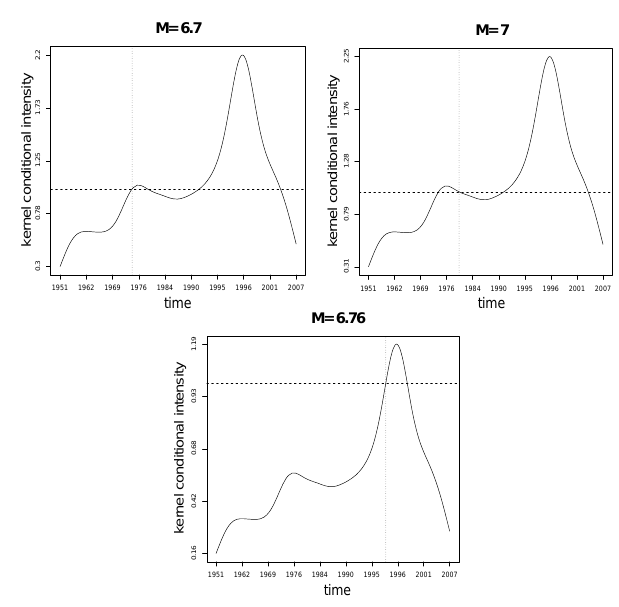
Fig. 5. Temporal kernel intensity conditioned to three big events, with magnitude M = 6 . 7 (top left), M = 7 (top right) and M = 6 . 76